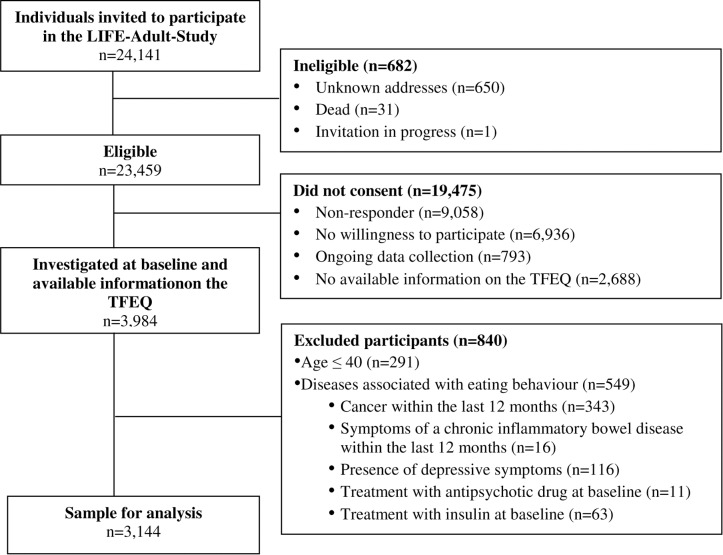
Sample attrition and sample for the Three-Factor-Eating-Questionnaire (TFEQ) factor analysis.